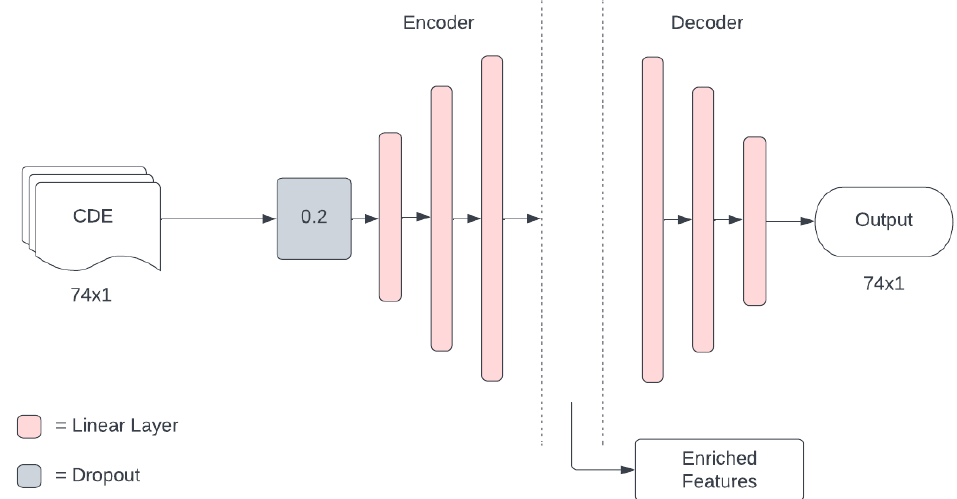
Figure 2. Denoising autoencoder schematic.